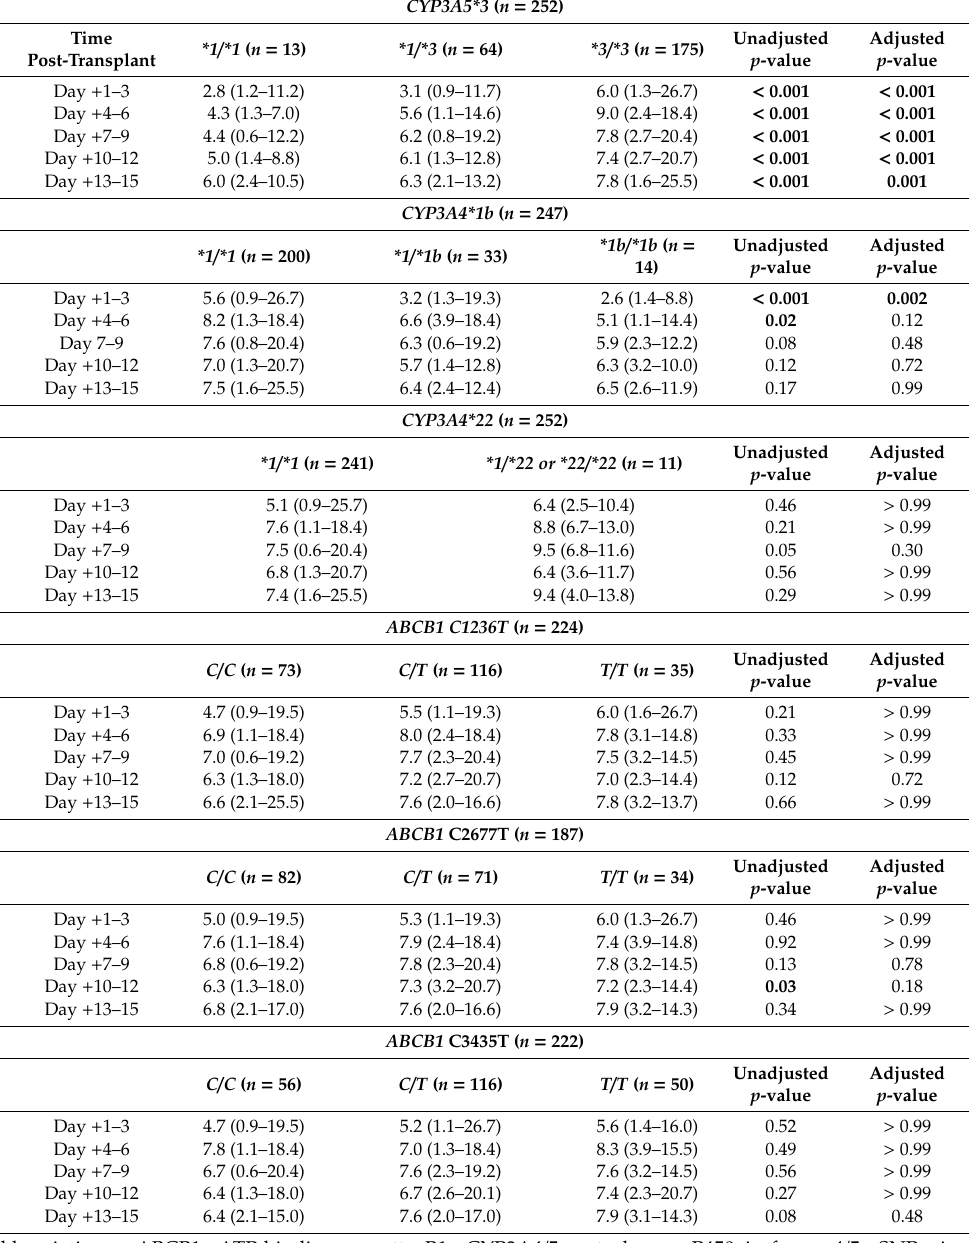
Table 3. Median steady-state tacrolimus trough concentrations during the first 15 days post-transplant. For each CYP3A5 and ABCB1 SNP, the time interval was divided into 3-day intervals because tacrolimus trough concentrations were measured every 3–4 days (on Mondays and Thursdays) during the first 15 days post-transplant. Median concentrations, with range, are reported. p < 0.05 was considered significant and bolded below. p values were adjusted for multiple comparisons using a Bonferroni